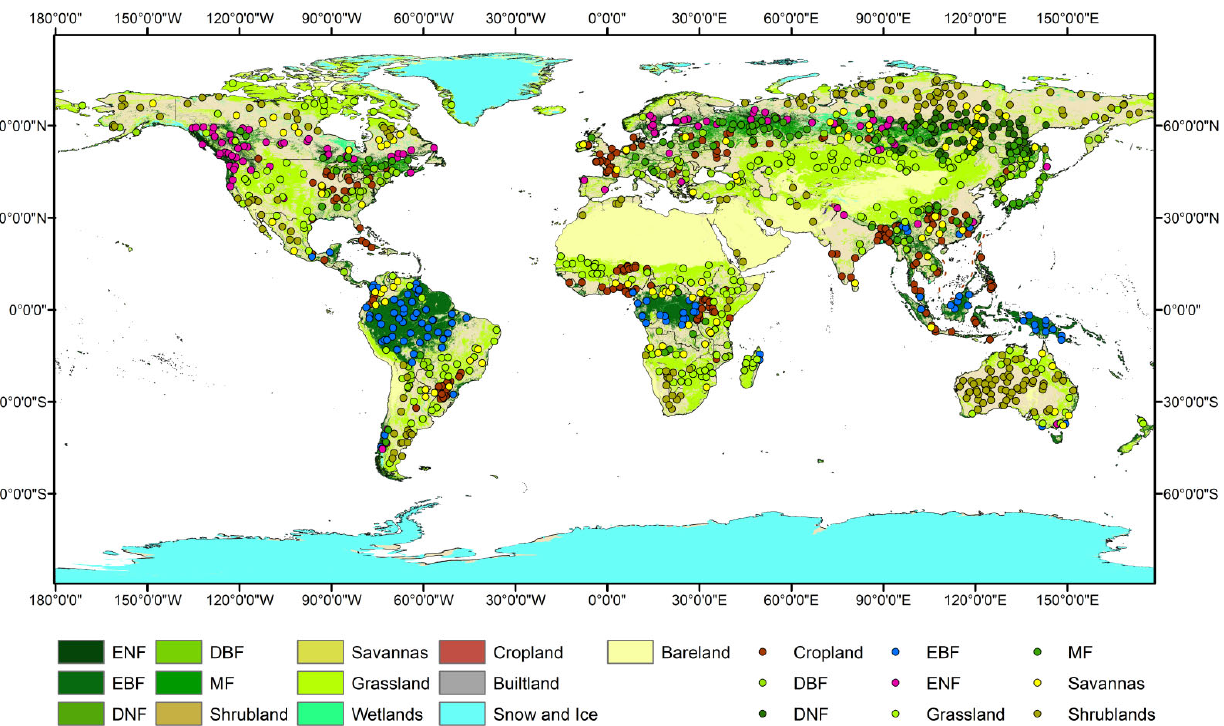
Figure 2. Distribution of sampling points and stable land cover types. 13 kinds of stable land cover types from 2001 to 2005 are extracted from the MCD12Q1.006 product. For 9 kinds of vegetation land cover types, 100 sampling points for each of the ENF, EBF, DBF, and MF datasets and 200 sampling points for each of the shrubland, savanna, grassland, and cropland datasets are obtained.